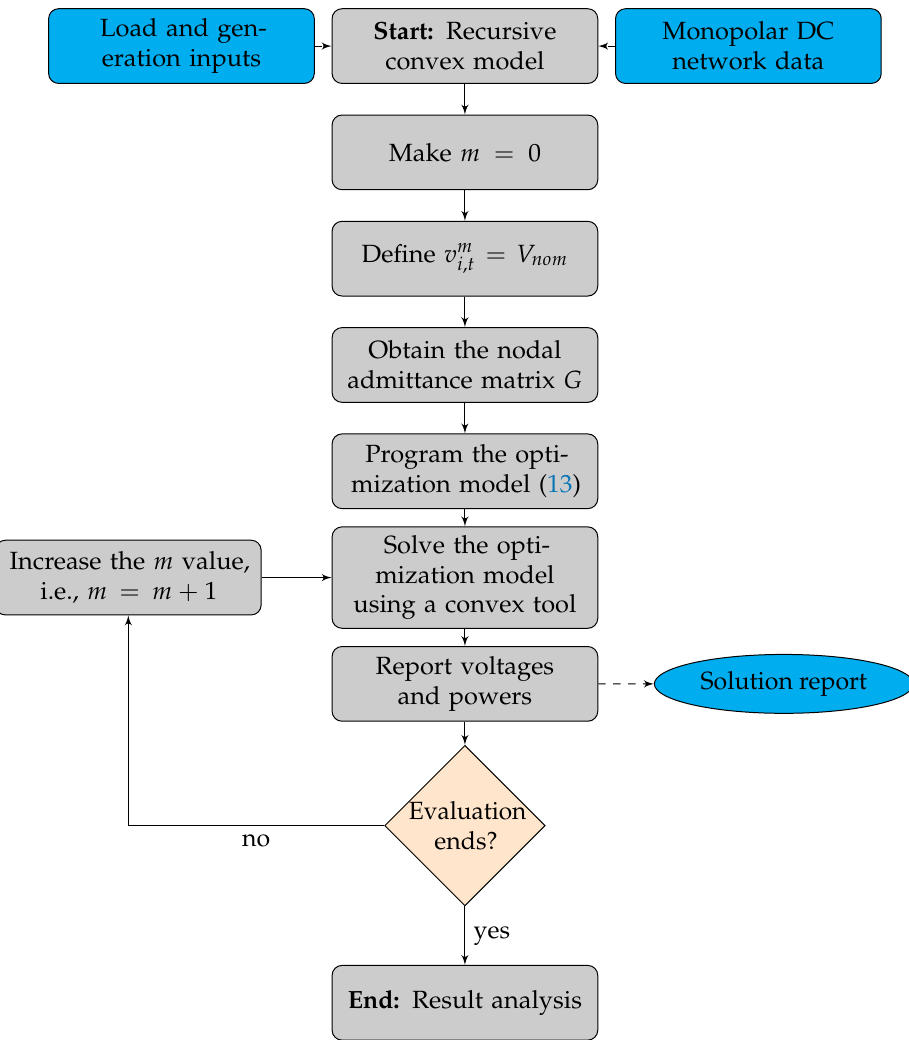
Figure 1. Recursive solution approach for the optimization model